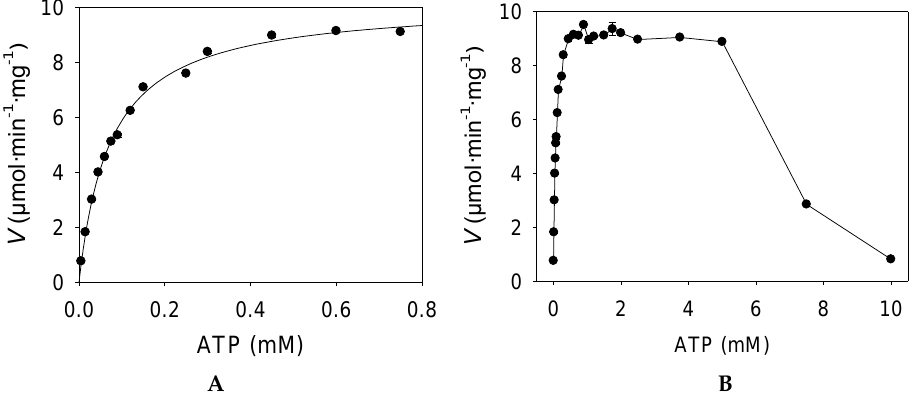
Figure 3. Kinase activity of the purified KGUK from C. necator was measured at increasing concentrations of ATP, maintaining a constant excess of KG (1.25 mM) as the phosphate acceptor and 2.1 μ g/mL of purified enzyme. ATP kinetics were carried out for kinetic constants calculation using a Mg 2 + excess concentration of 5 mM ( A ). To evaluate the e ff ect of higher concentrations of ATP on the enzyme activity, additional assays were performed increasing the Mg 2 + concentration to 25 mM ( B ). When ATP concentrations over 5 mM were used, a strong decrease in the kinase activity was